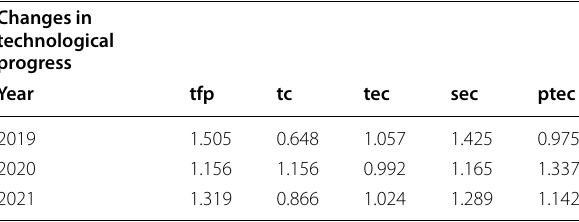
Table 5 Analysis of dynamic changes in resource allocation